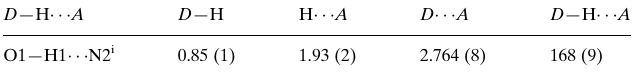
Hydrogen-bond geometry (A˚ , (cid:3)